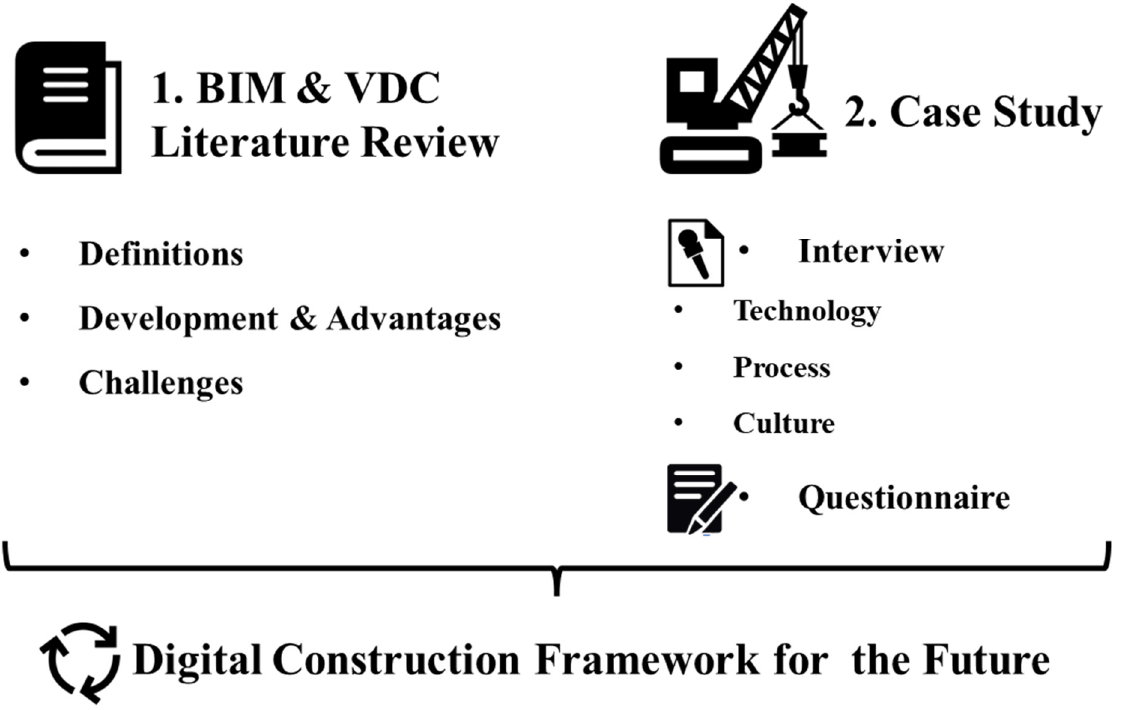
Figure 1. Methodology of researching and proposing a framework for promoting development .